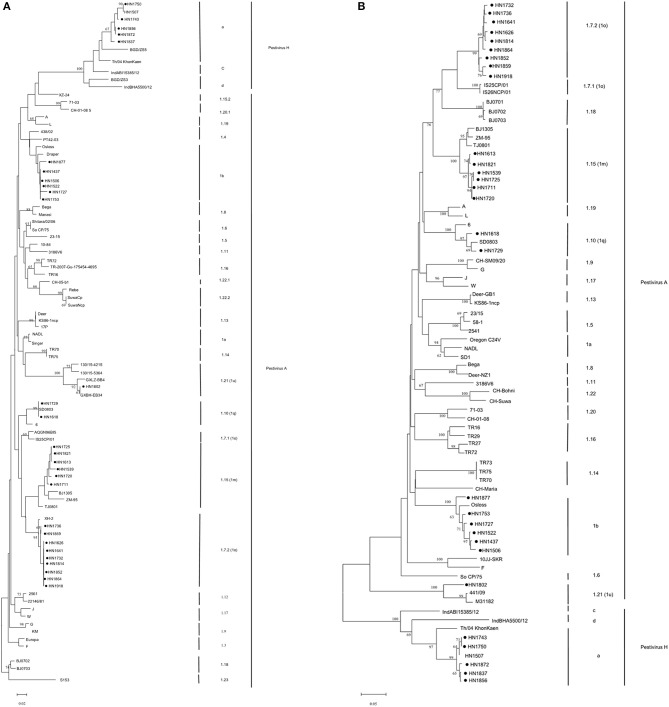
Phylogenetic analysis of bovine Pestivirus from cattle in backyard farms in Central China, and reference strains using the 5′-UTR (A) and Npro (B) sequences. Bootstrap analyses that were supported by >60% of 1,000 replicates are indicated in nodes. Henan pestivirus isolates in this work are highlighted with a symbol (•).